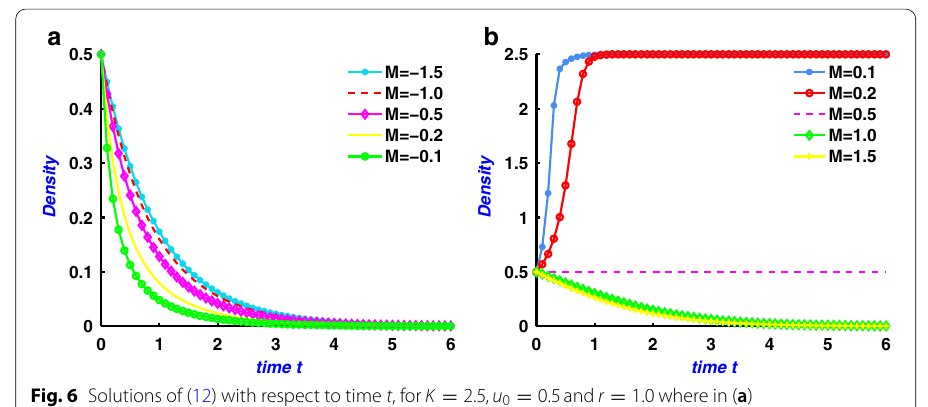
Fig. 6 Solutions of (12) with respect to time t , for K M 1.5, 1.0, 0.5, 0.2, 0.1 and in ( b ) M = − − − − −